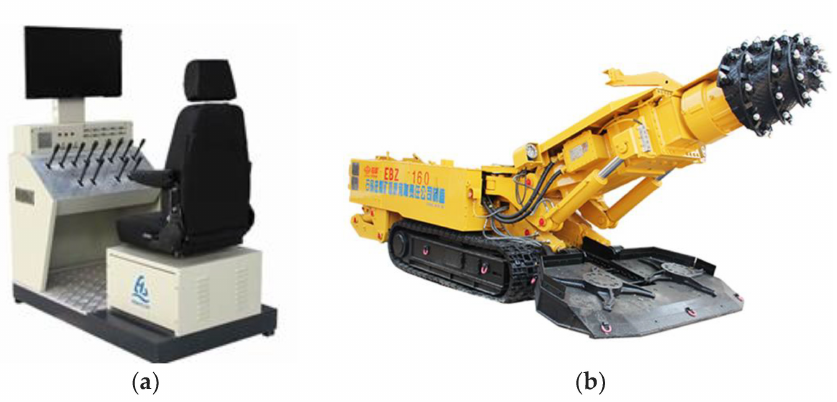
Figure 3. The roadheader MH620 Simulator ThoroughTec [2]: ( a ) roadheader view, ( b ) full mission simulator.